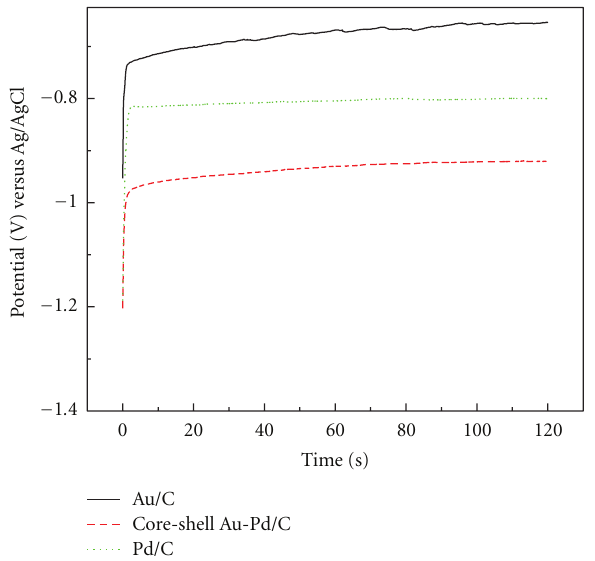
Figure 6: Chronopotentiometry curves of Au/C, core-shell Au- Pd/C and Pd/C electrodes.